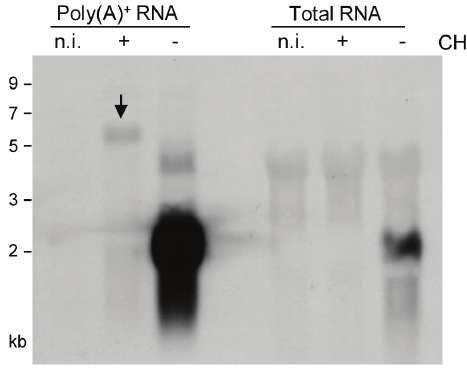
Figure 2. Identification of m164 transcripts by Northern blot analysis. Total cellular RNA or poly(A) + RNA were isolated at 3 h p.i. from MEF infected in the presence (+) or absence (–) of CH (100 µg/mL) and were analyzed by Northern blotting using a DIG-labeled m164-specific RNA probe. The arrow highlights a specific band of >5 kb representing an IE